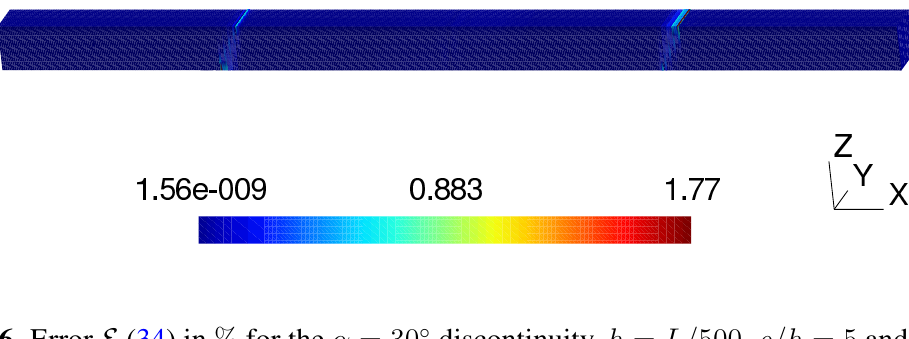
Figure 6. Error E (34) in % for the α = 30 ◦ discontinuity, h = L/ 500 , ρ/h = 5 and support = 60 ρ . Note that the relevant error is localized along the inclined interface. width ℓ ρ